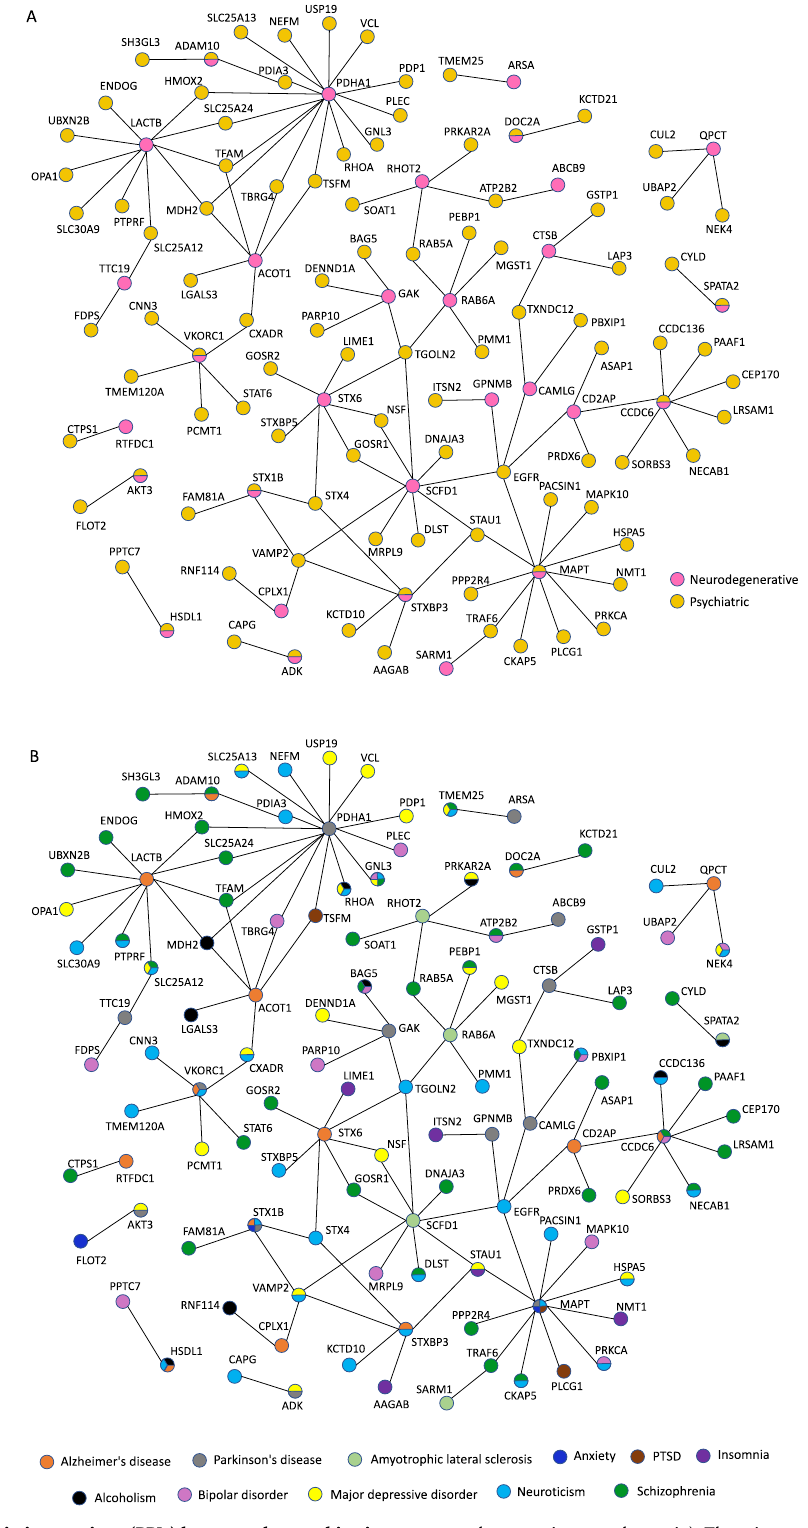
neurodegenerative causal protein). There is a total of 118 psychiatric and neuro- degenerative causal proteins that have physical PPIs with one another. See com- plete results in Table S8. B PPIs between the psychiatric causal proteins and neurodegenerative causal proteins. The same information in A is presented but each brain trait is depicted with a distinct color. See complete results in Table